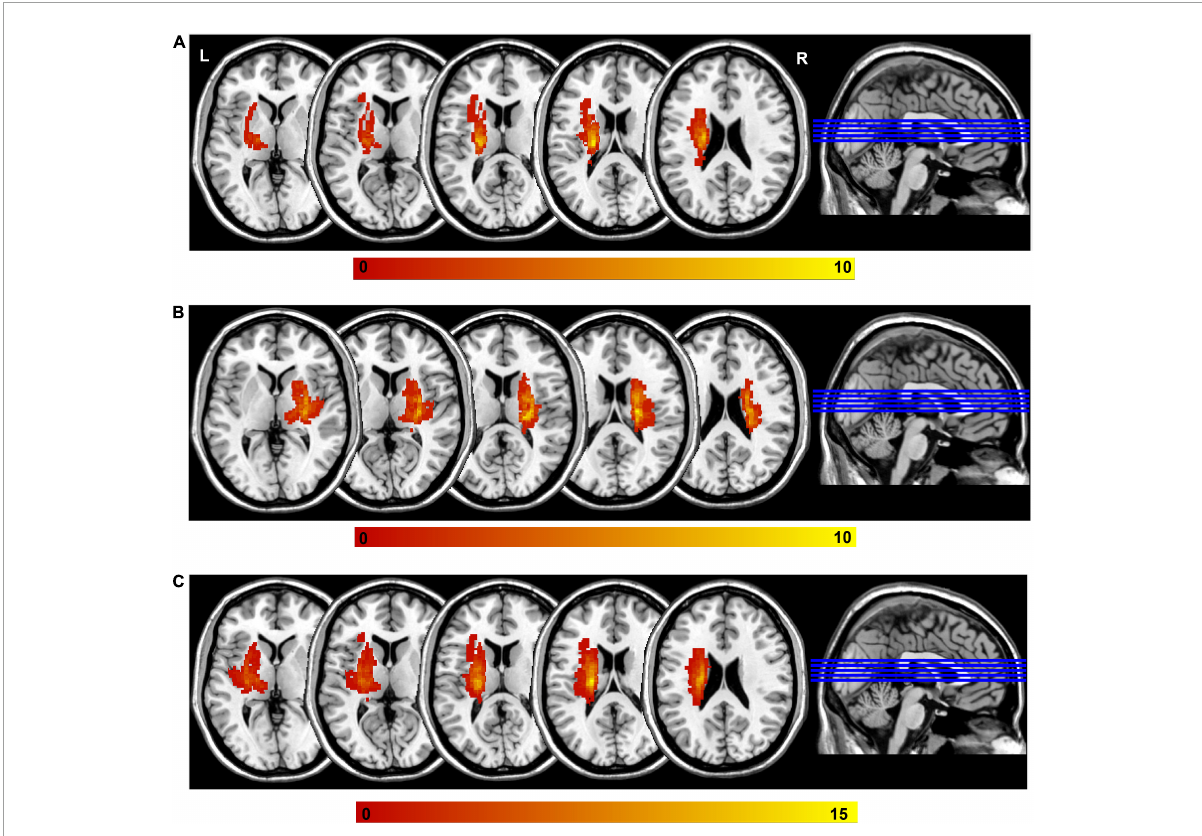
FIGURE1 Lesion overlap across stroke participants. (A) The left-sided lesions; (B) the right sided lesions; (C) the overlapping of all lesions by mirroring the right lesions to the left side. Color bar indicates the subject number of lesion overlap. L, left; R,